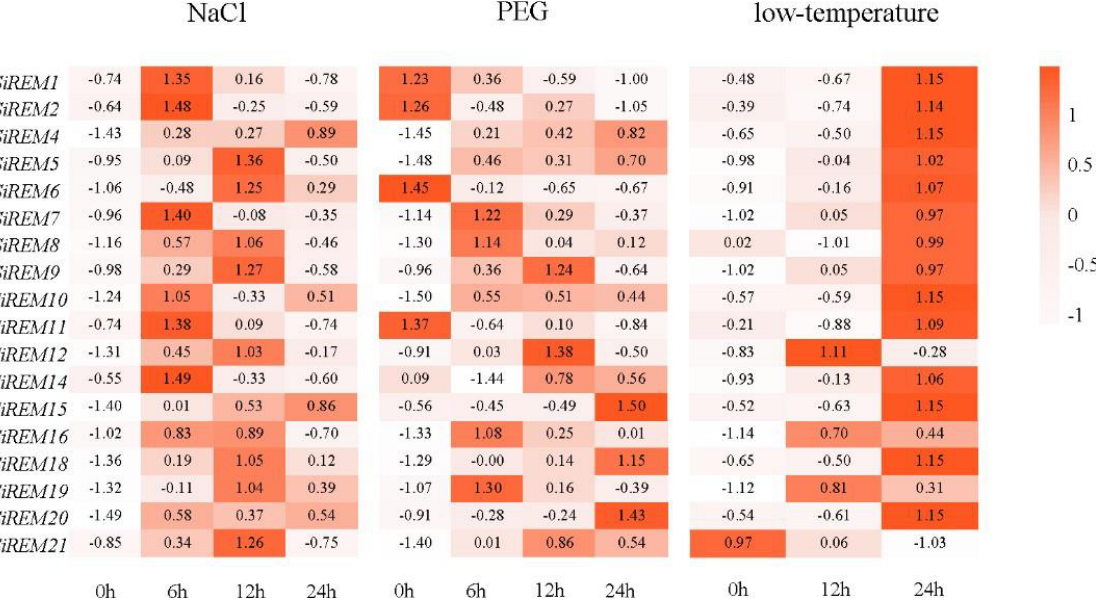
Figure 6. Expression profile of SiREM genes under different hormone treatments. Orange bars indicate up-regulation, white bars indicate down-regulation, and the intensity of the color indicates the intensity of expression.